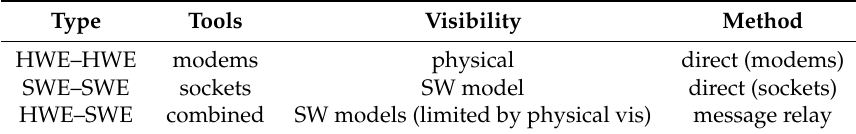
Table 1. Types of communication connection in MR simulation